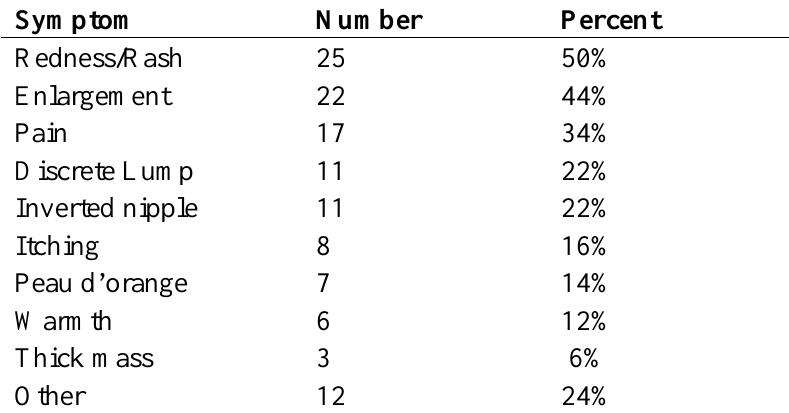
Table 2. Presenting Symptoms.